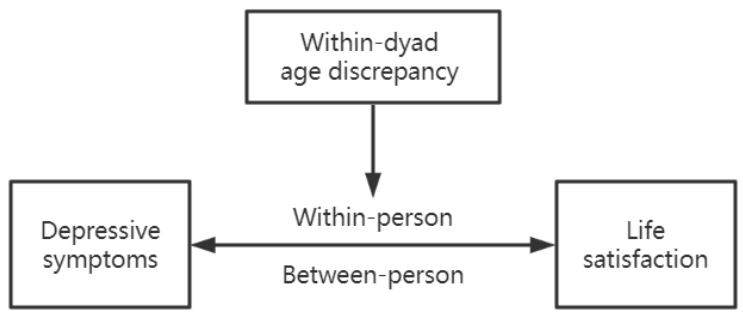
Figure 1. The conceptual model of associations between variables.